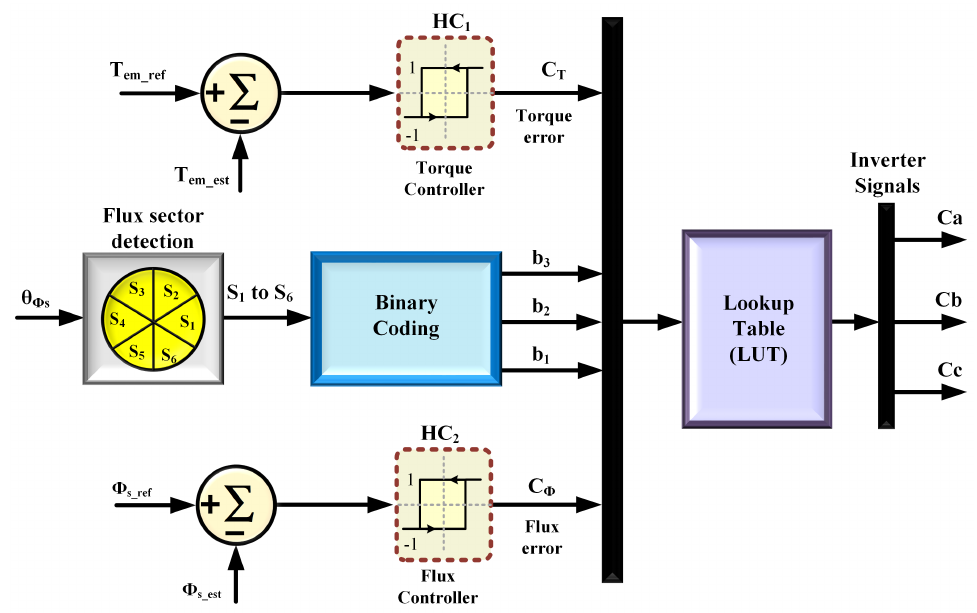
Figure 1. Block diagram of a conventional DTSFC